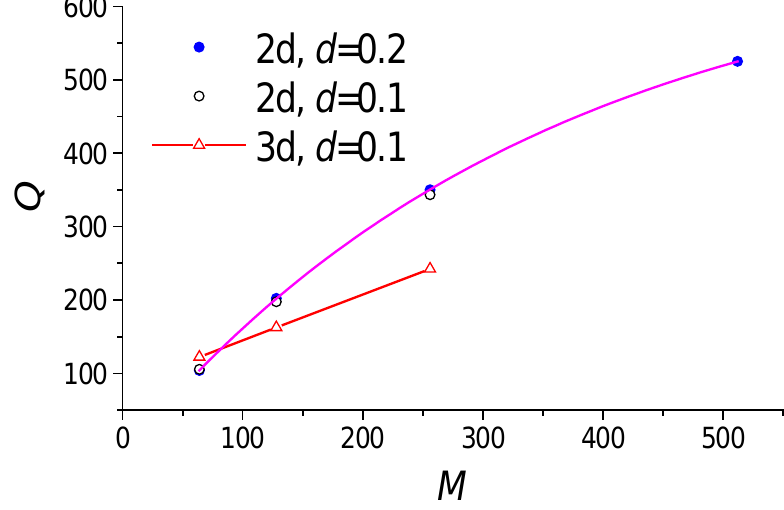
Figure 9. Dependence of the quality factor Q on the number of grating strips M . W = H =1.0 µ m. The simulation by 2D FDTD and 3D FDTD.